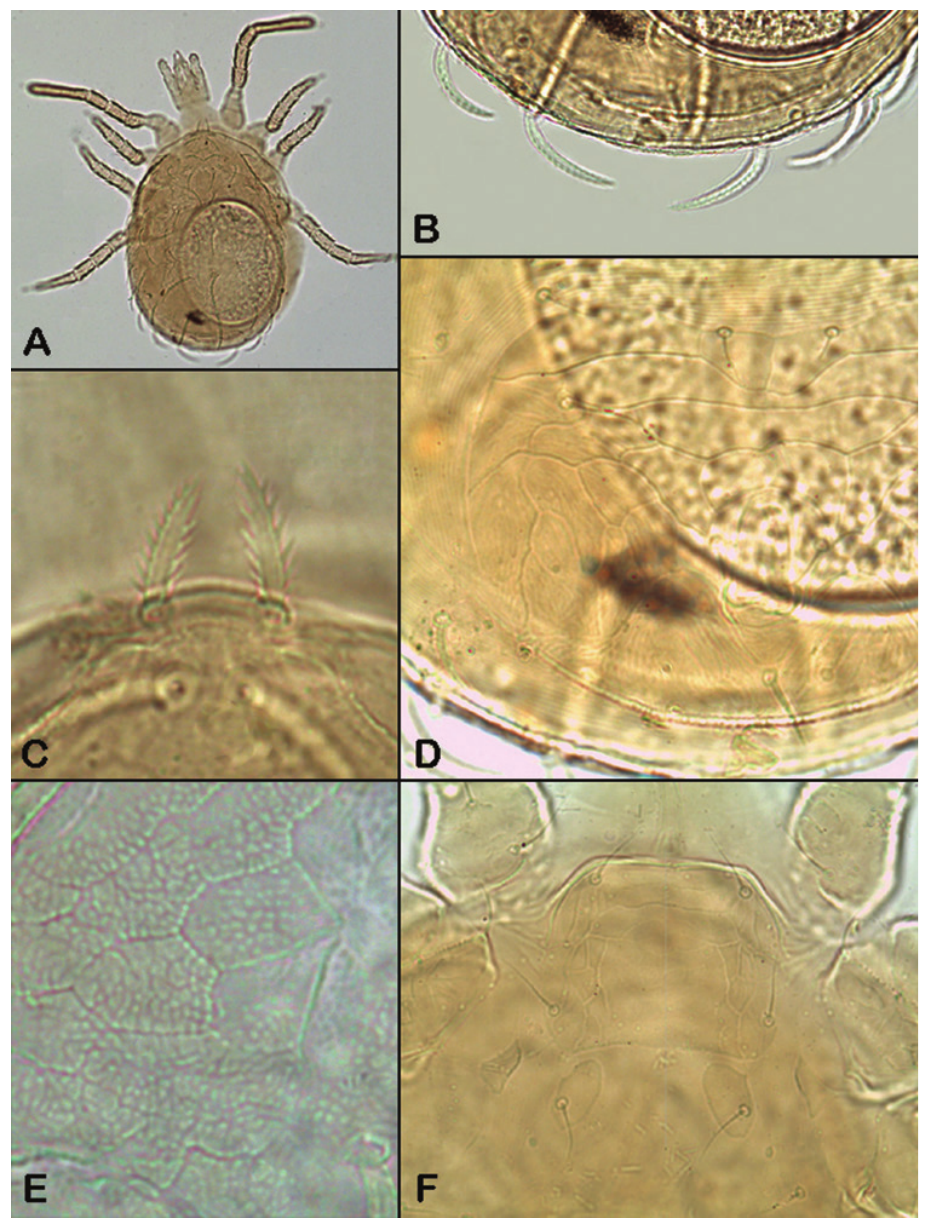
Plate 40. Kleemannia insignis , female. A Dorsal idiosoma with legs B Posterior margin of idiosoma C Setae j1 D Ventrianal shield, a part E Dorsal shield sculpture F Sternal shield and metasternal